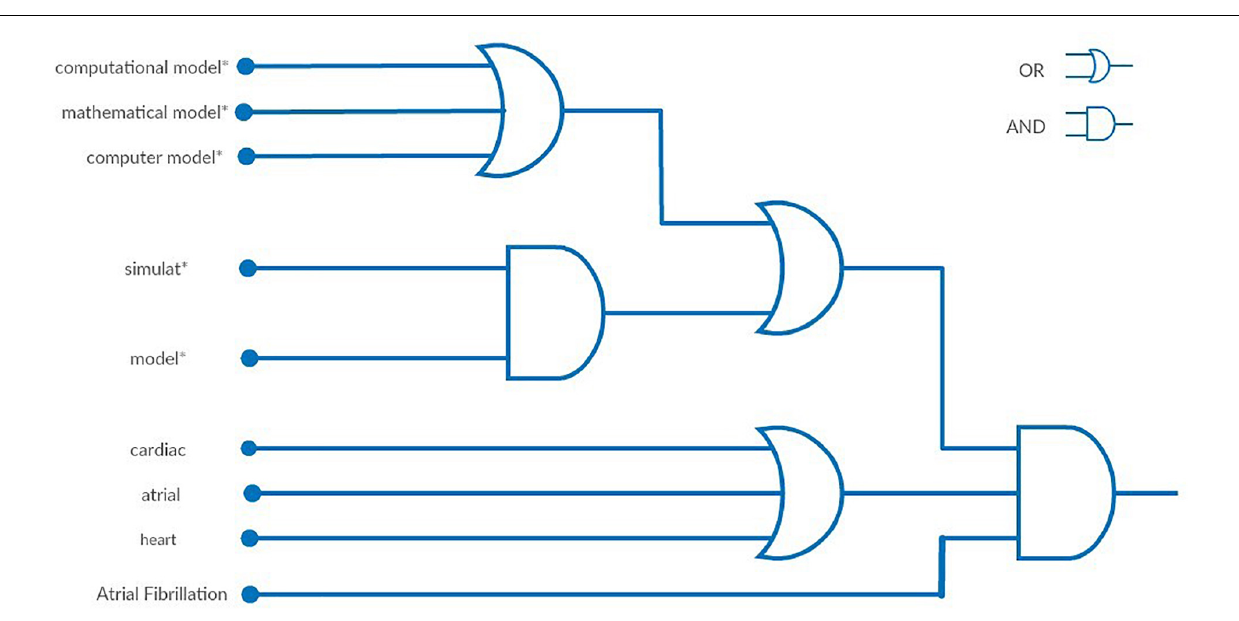
( Figure 2 ). In this step, the words and phrases identified were searched in the abstract, the title or the indexed keywords. The whole literature search, its evaluation, and categorization were